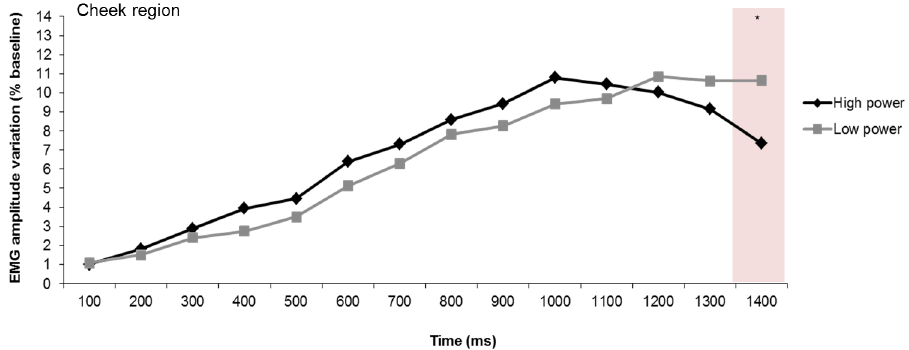
Fig 9. Electromyographic (EMG) amplitude variations over the cheek region, illustrating the power effects across time. * p <